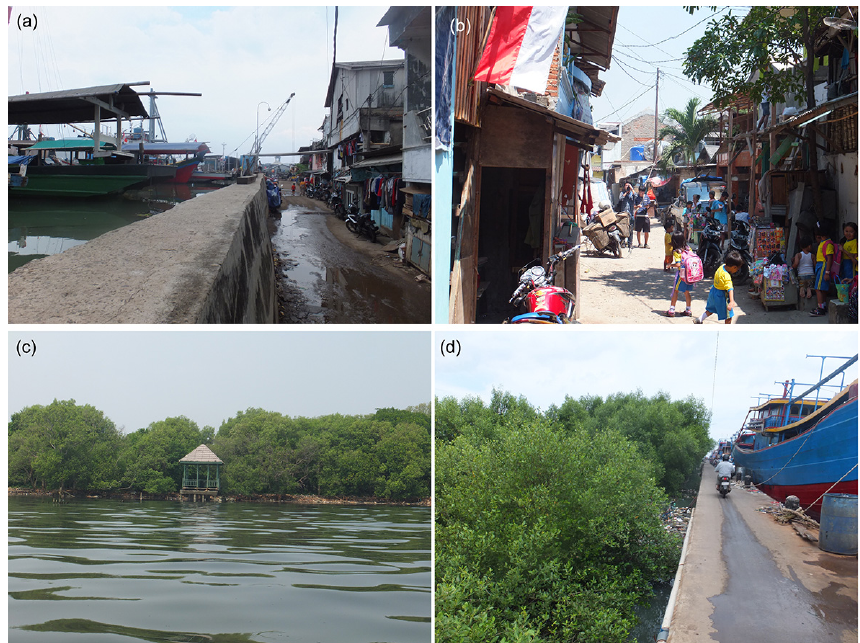
Figure 2. Coastal areas around Jakarta (photos taken by the authors during field surveys in the period between May 2015 and February 2016). (a) A thin coastal dyke protecting a community experiencing rapid subsidence (district of Pluit, northern Jakarta). Leakage of seawater through a concrete joint was observed during the authors’ visual inspection on 6 February 2016. The sea level was 1.3m higher than the road. (b) The town centre of Pluit, with a high population density and long narrow paths. (c) Mangrove conservation site in Jakarta (see Fig. 3 for its location) (d) Mangrove rehabilitation site in the Jakarta Fishing Port (see Fig. 3 for its location). The mangrove belt is around 20m thick and can effectively protect the port basin from wind